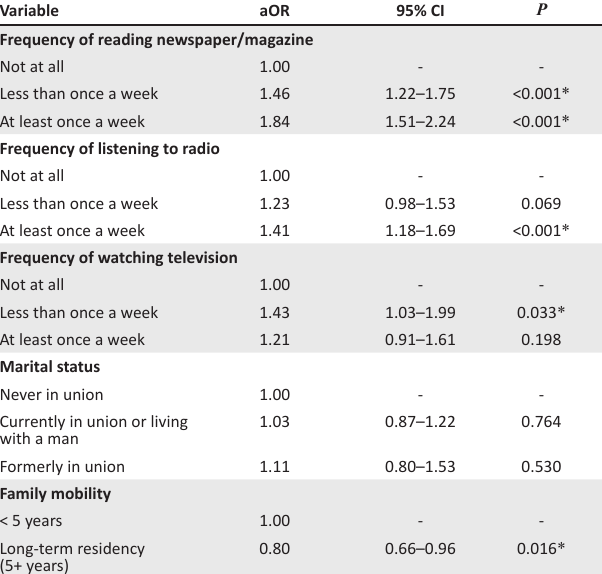
TABLE 3 (Continues...): Measures of the association of factors linked to HIV self-testing knowledge amongst South African women.